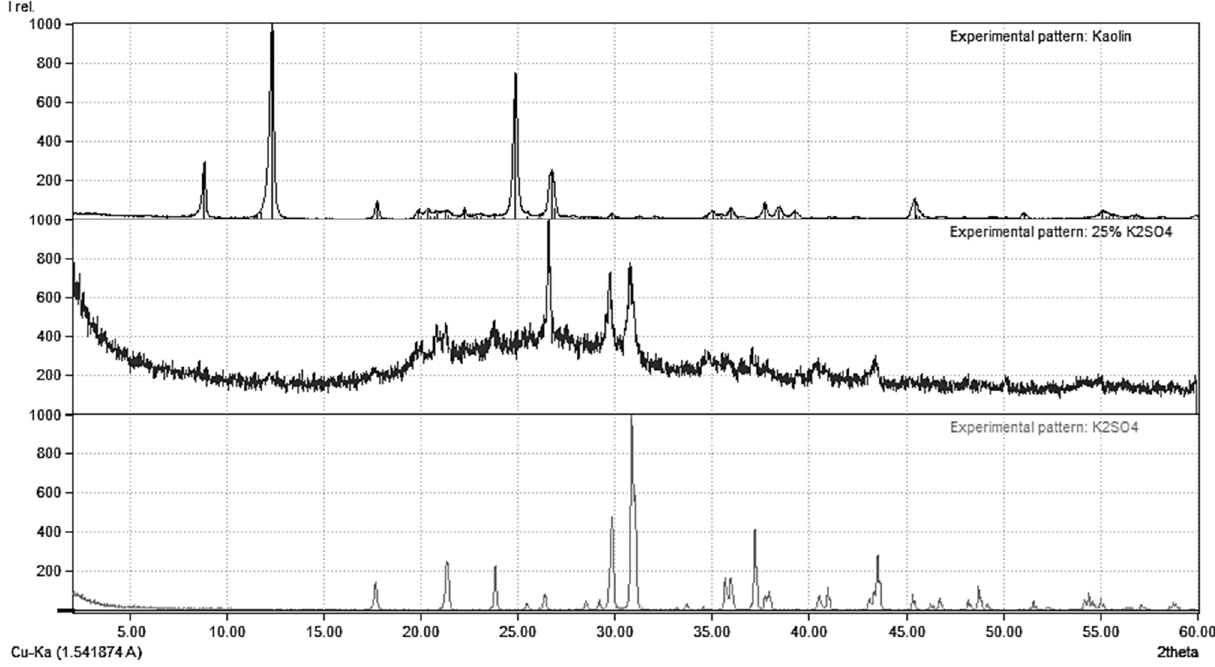
Figure 2. XRD patterns of kaolinite-K 2 SO 4 system milled at speed 700 rpm for 120 min.